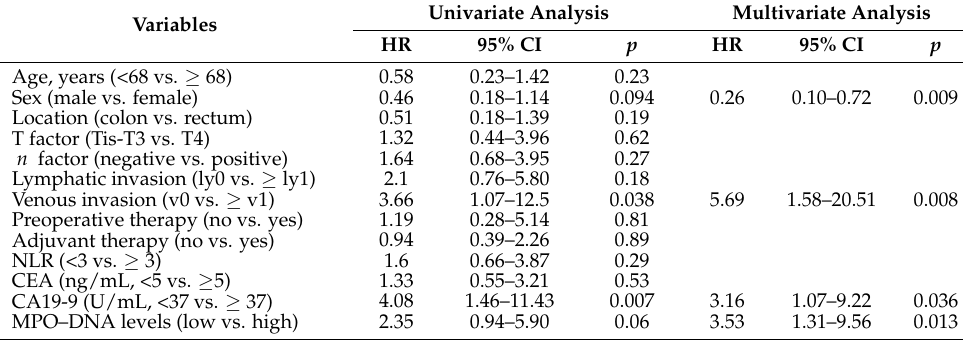
Table 2. Univariate and multivariate analysis using clinicopathological characteristics and serum MPO–DNA levels for RFS in 67 CRC